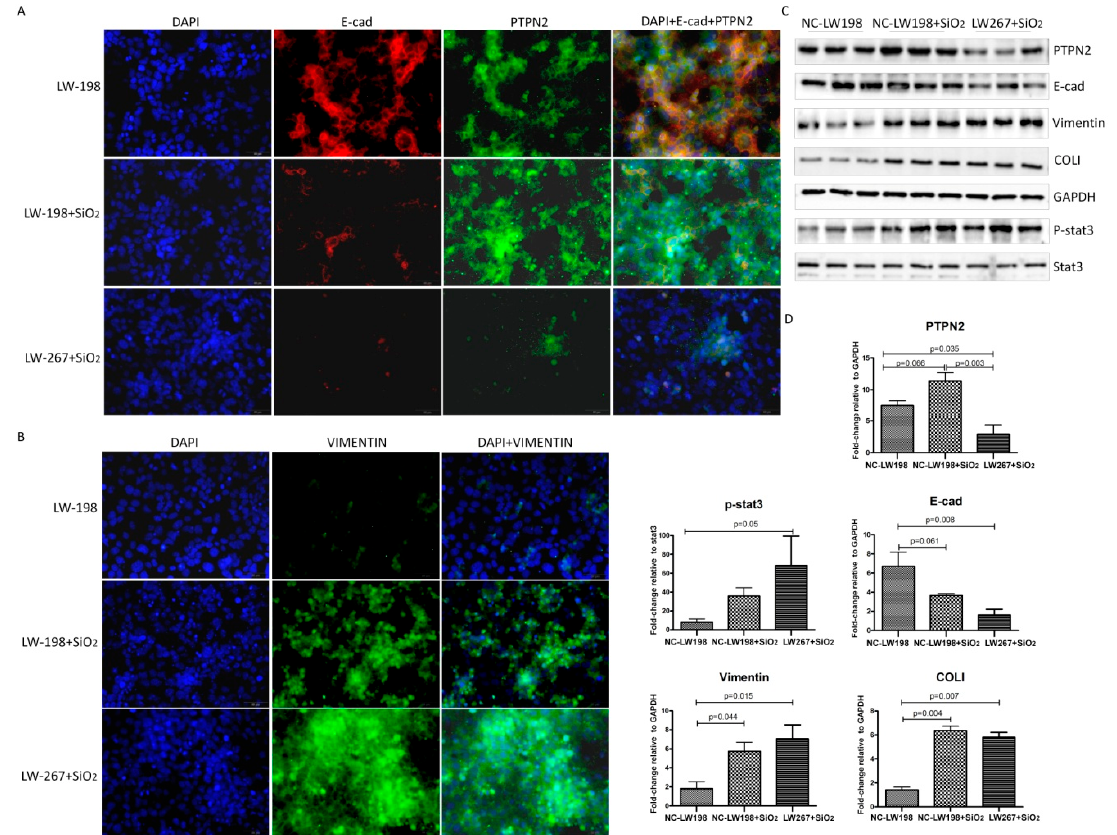
Figure 8. Effect of PTPN2 gene silencing on SiO2 stimulated MLE-12 cells. ( A ) Immunofluorescent staining for PTPN2 and E-cad expression in NC-LW198 and LW267 cells with SiO 2 ; Scale bars: 50 μ m. ( B ) Immunofluorescent staining for Vimentin expression in NC-LW198 and LW267 cells with SiO 2 ; Scale bars: 50 μ m. ( C ) Western blot for the expression levels of PTPN2, E-cad, Vimentin, and p-STAT3 in NC-LW198 and LW267 cells with SiO 2 . ( D ) The corresponding densitometry data for the expression levels of PTPN2, E-cad, Vimentin, and p-STAT3 in NC-LW198 and LW267 cells with SiO 2 . Relative densities of PTPN2, E-cad, and Vimentin were normalized to GAPDH, and the relative density of p-STAT3 was normalized to STAT3. The relative expressions were expressed as the fold-change of specific bands in the negative control group. Bar graphs are the mean ± SD of two separate experiments, each performed in triplicate. Statistical analysis was performed using a t-test with SPSS20.